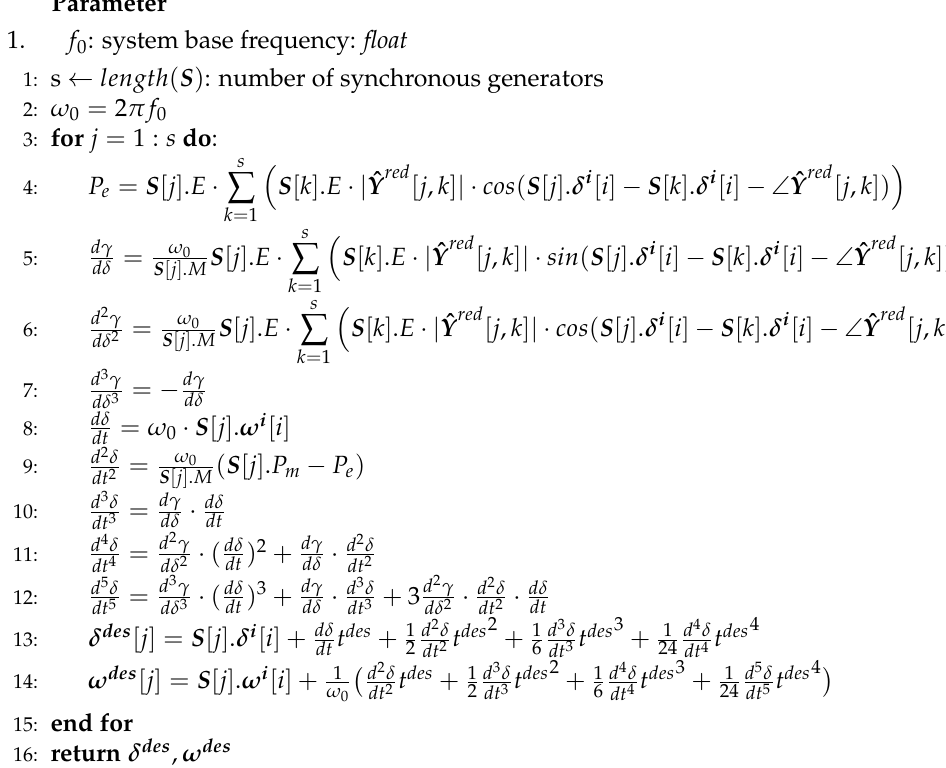
Algorithm A13 clarifies the steps of the third refinement scheme for estimations of CCT with EEAC. The steps of the other two refinement schemes are not presented due to their